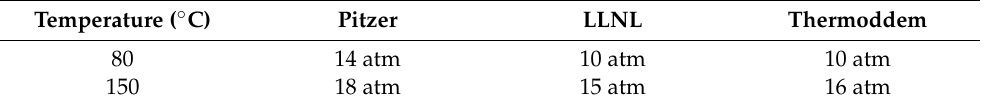
Table 8. Results of the saturation pressure of SsF gas for each database at two temperature steps. Temperature ( ◦ C) Pitzer